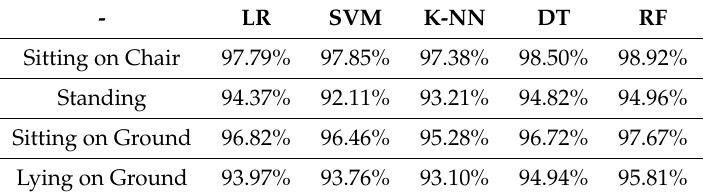
Table 17. F-1 score using different algorithms for three